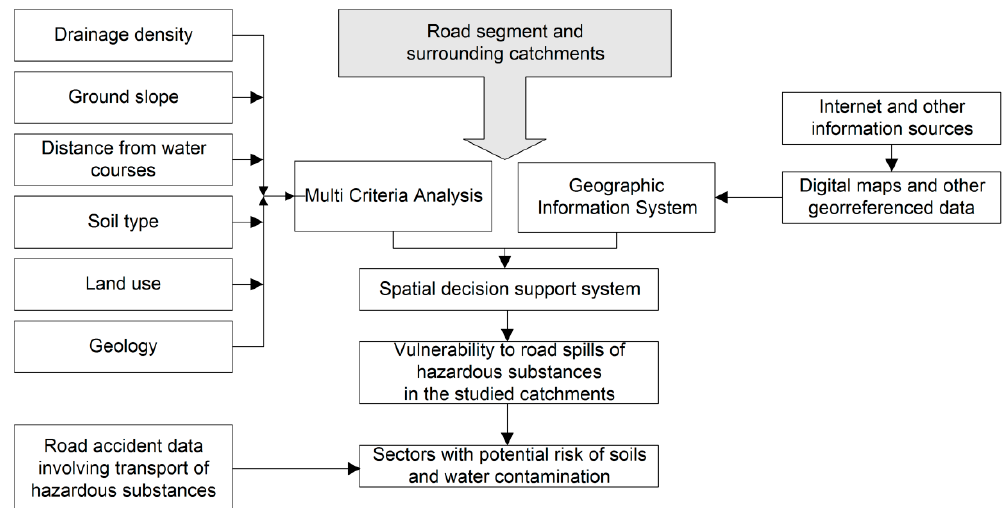
Figure 2. Flowchart illustrating how contamination risk has been assessed in the present study, associated with spills of hazardous substances following a road accident